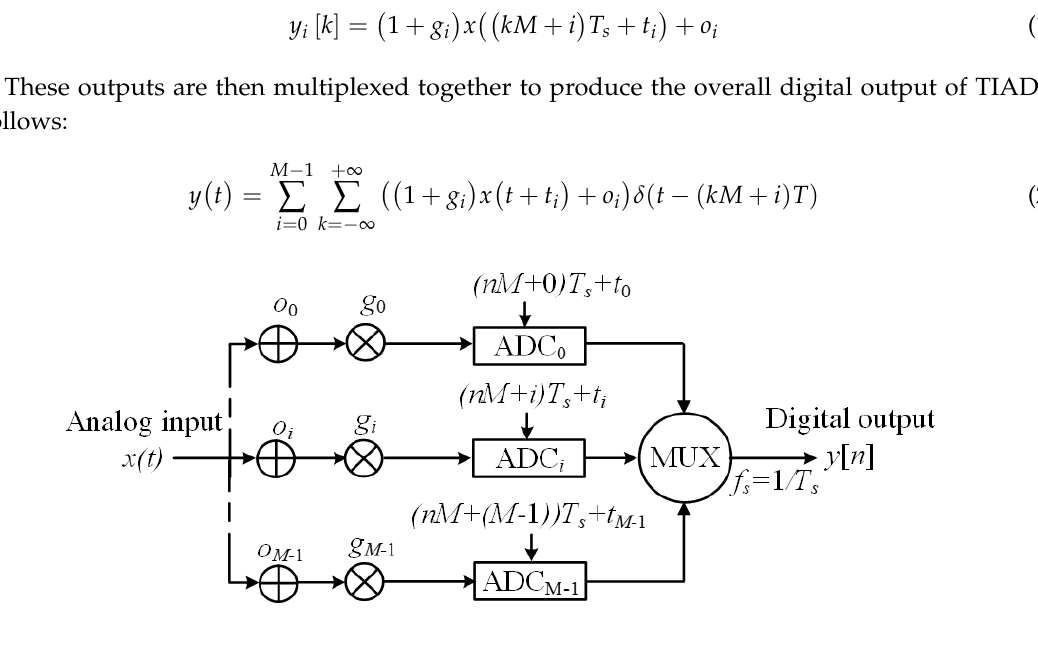
Figure 2. An M -channel architecture of TIADC with offset, gain, and timing